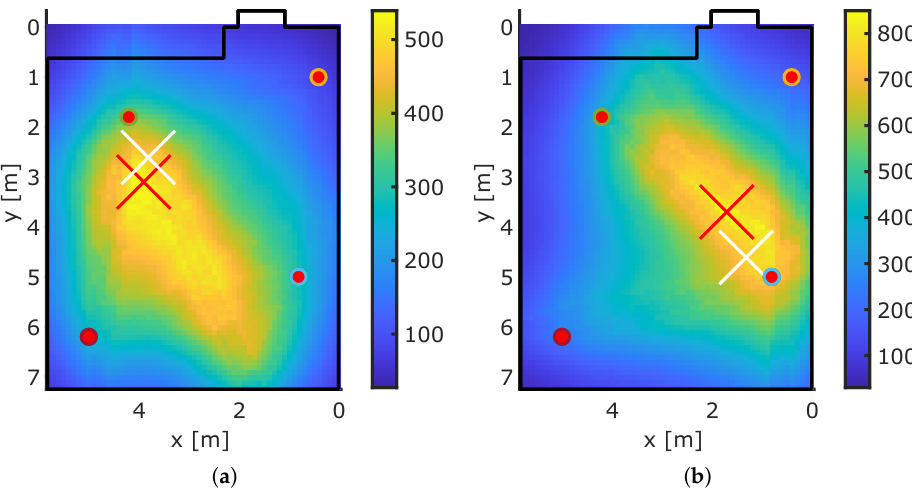
Figure 13. Exemplary MA-RTI results. ( a ) Exemplary Pos. 1. ( b ) Exemplary Pos. 2.